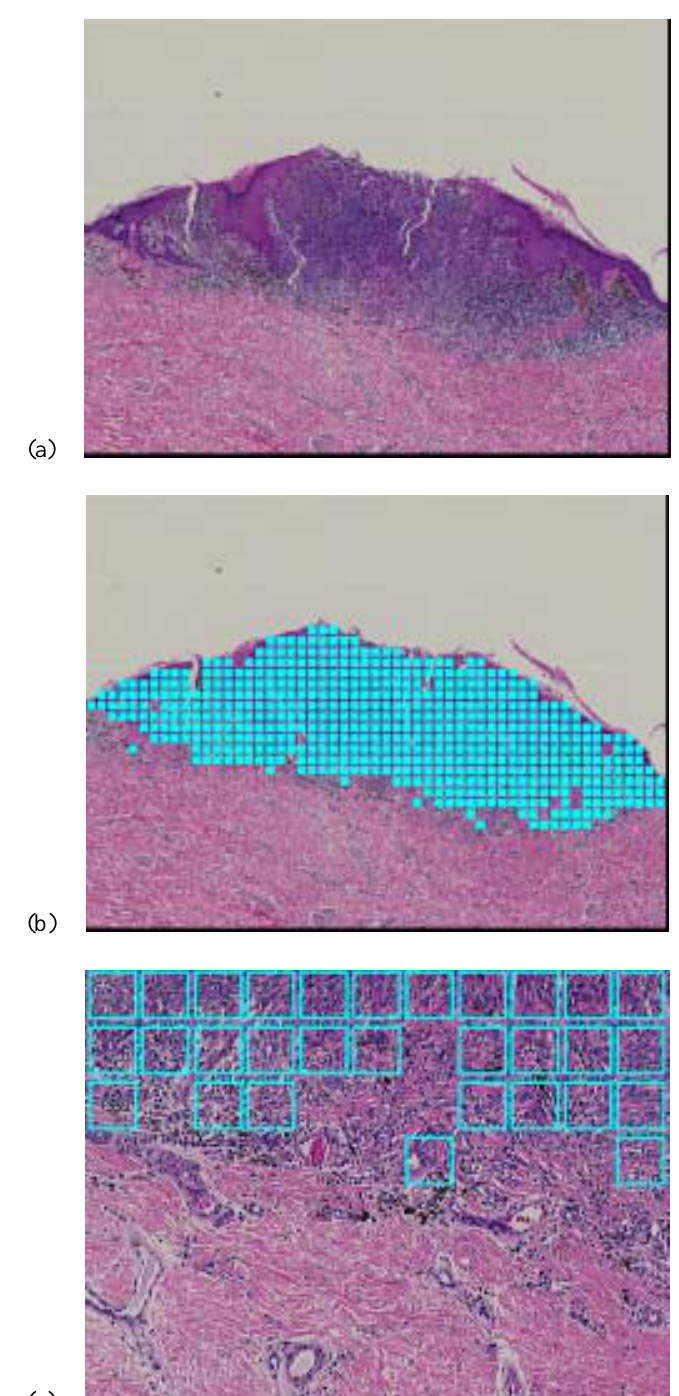
Fig. 1. Malignant melanoma, Breslow index 1.9 mm, cross-sectional area 15.9 mm 2 , haematoxylin–eosin. (a) Zoomed image of the whole lesion (1 pixel = 6.5 µ m); (b) zoomed image of the whole lesion with the elements detected as melanoma tissue overlayed by filled blue squares (1 pixel = 6.5 µ m); (c) original digital image from the base of the lesion with the elements detected as melanoma tissue marked by open blue squares (1 pixel = 1.3 µ